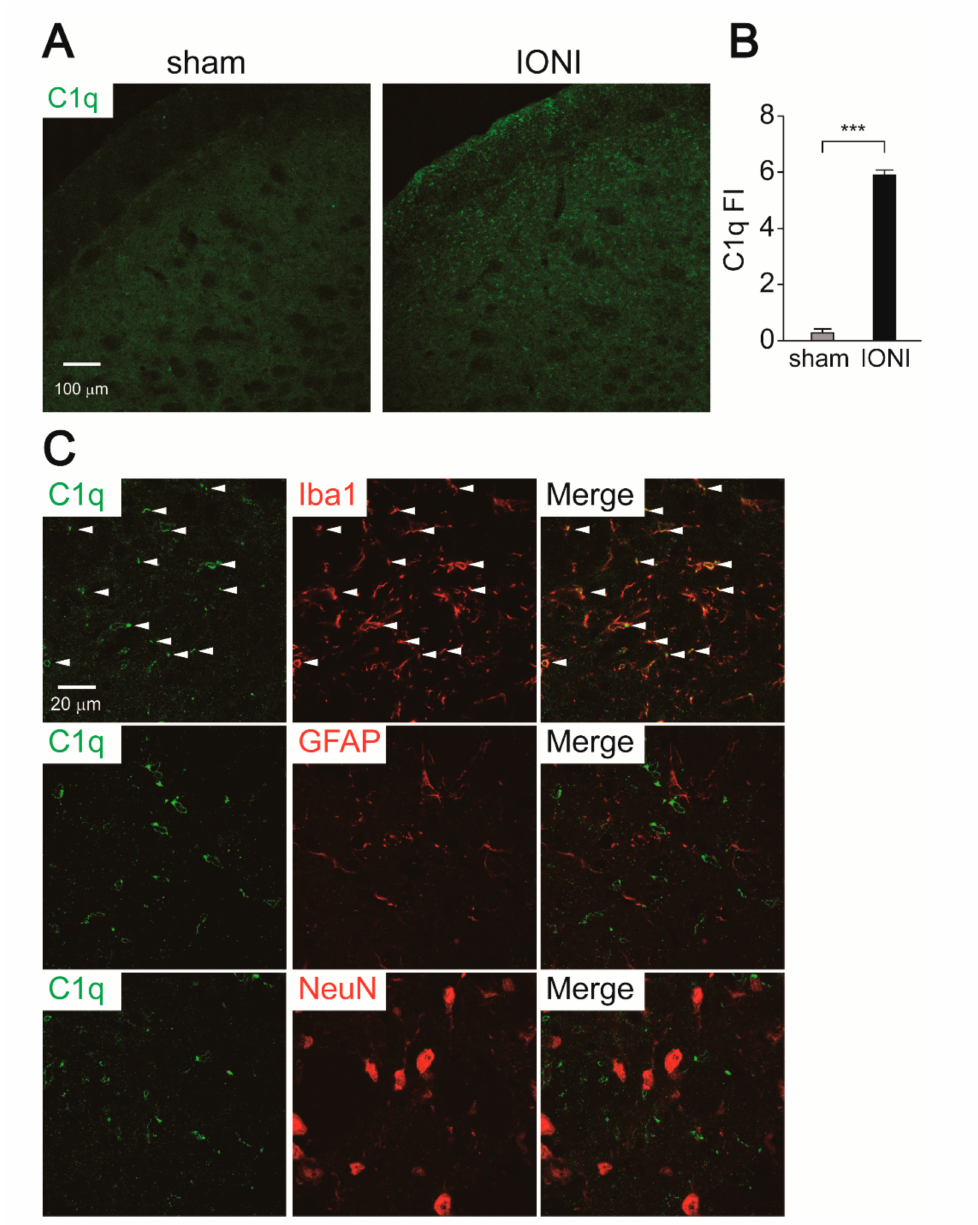
Figure 5. Induction of C1q in the Vc following IONI. ( A ) Representative images of C1q immunofluorescence in the Vc on day 7 of sham and IONI rats. ( B ) C1q fluorescence intensity (FI) in the Vc 7 days after IONI. Sham: n = 5, IONI: n = 5, unpaired Student’s t -test, *** p < 0.001. ( C ) The images show double staining of C1q and Iba1, GFAP, and NeuN in the Vc. Arrowheads indicate colocalization of C1q and Iba1